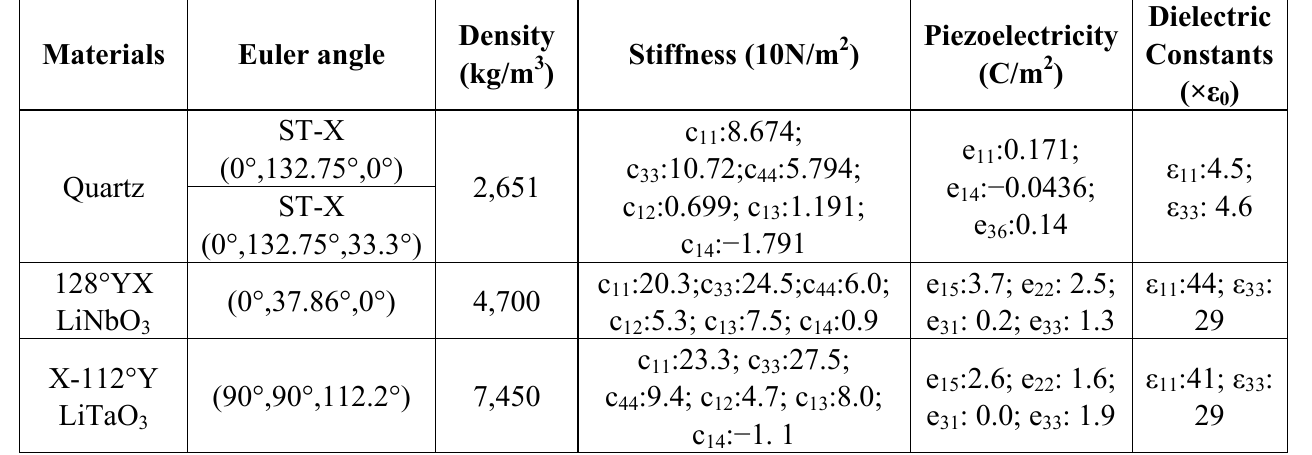
Table 1. The mechanical parameters of some common